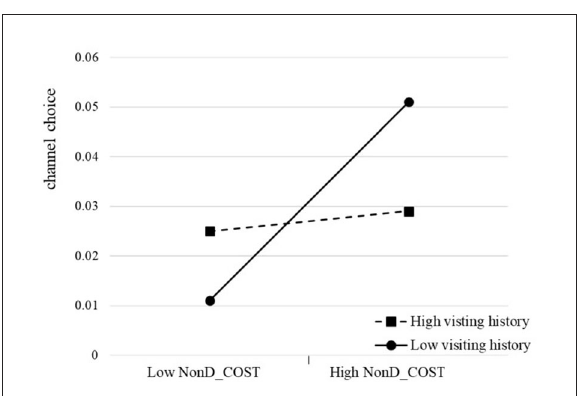
FIGURE3 The moderating effect of visiting history on channel